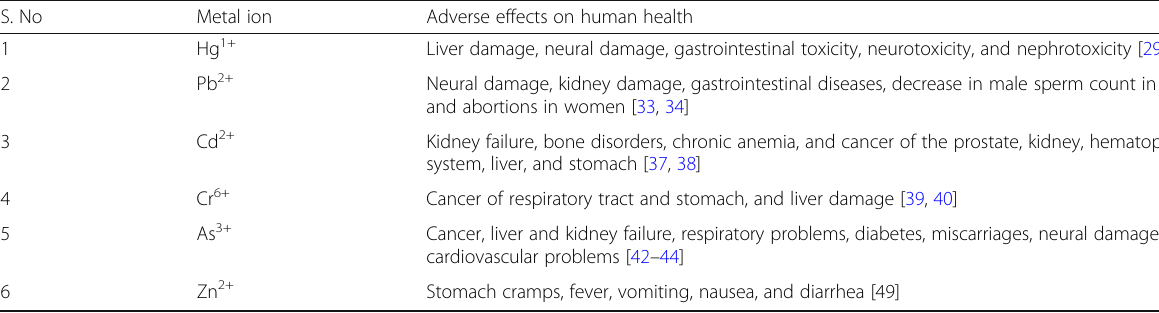
Table 1 Adverse effect of heavy metals on human health S. No